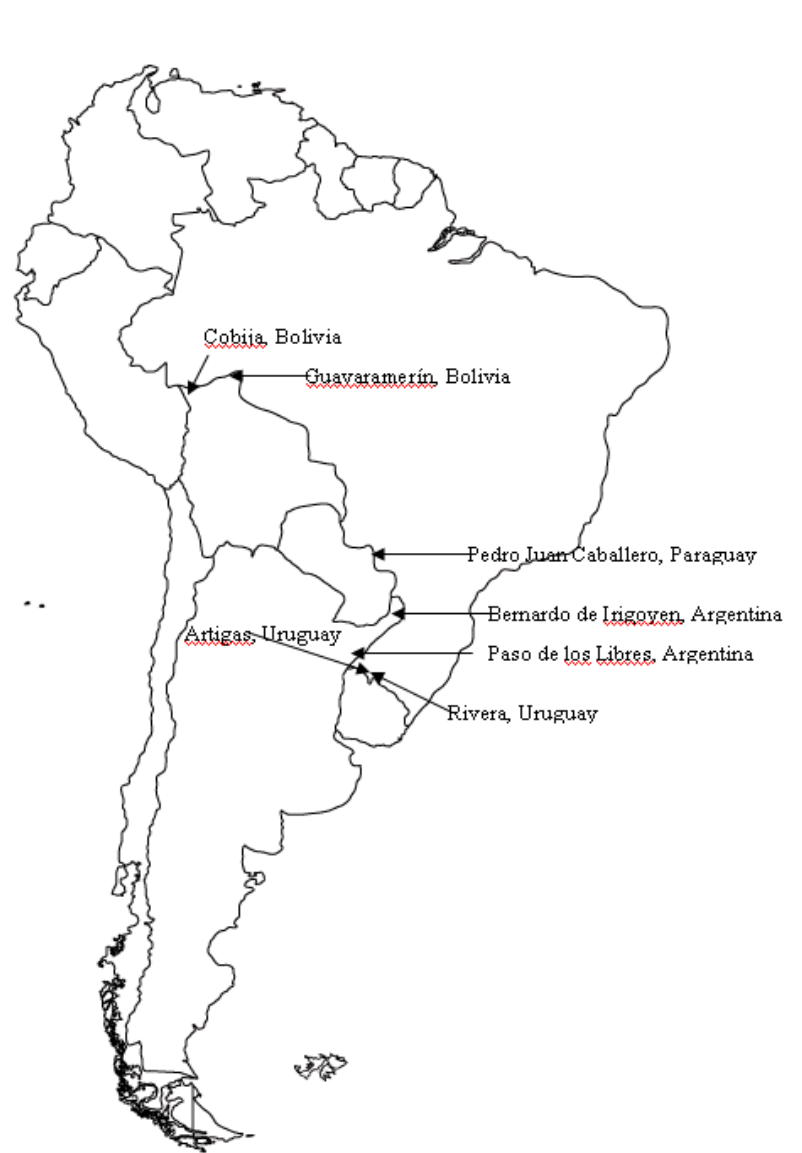
Figure 1: Approximate locations of the Spanish-Portuguese